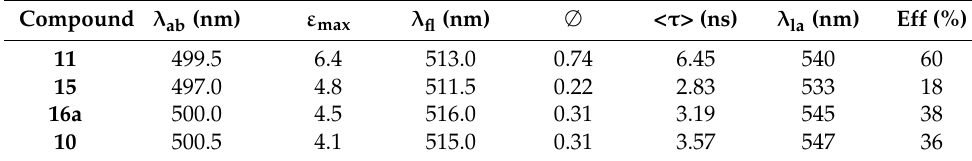
cence ( λ fl ) wavelength, molar absorption ( ε max ) (10 4 M − 1 cm − 1 ), fluorescence quantum yield ( ∅ ), and amplitude-average lifetime (< τ >). 2 Recorded under a hard irradiation regime; dye concentration 2 mM. Peak wavelength for the laser emission ( λ la ) and efficiency (Eff (%)) defined as the ratio be- tween the energy of the laser output and the pump energy incident on the cell surface.